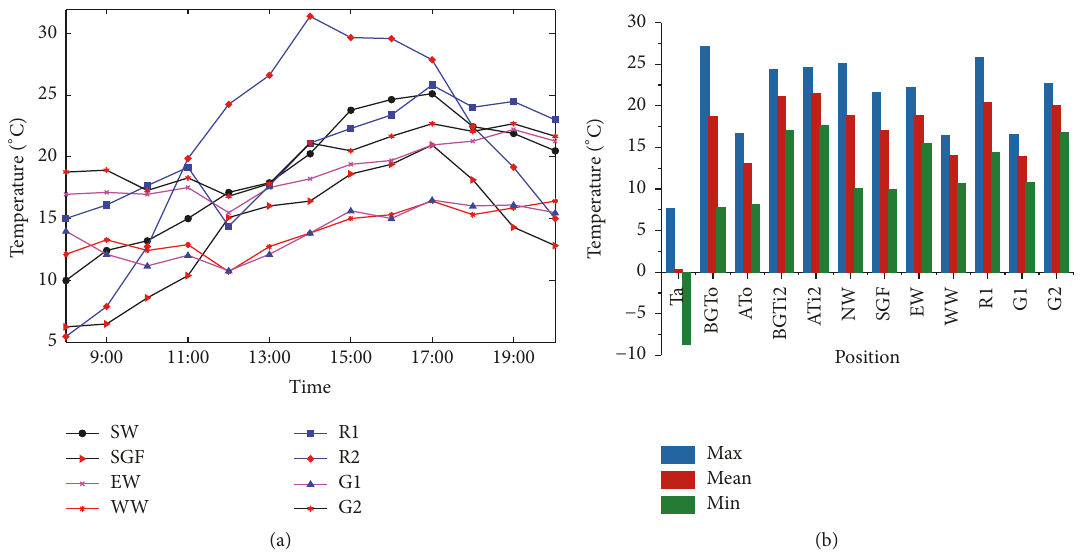
Figure 11: The inner surface temperature of the building envelope: (a) dynamic variation; (b) statistical